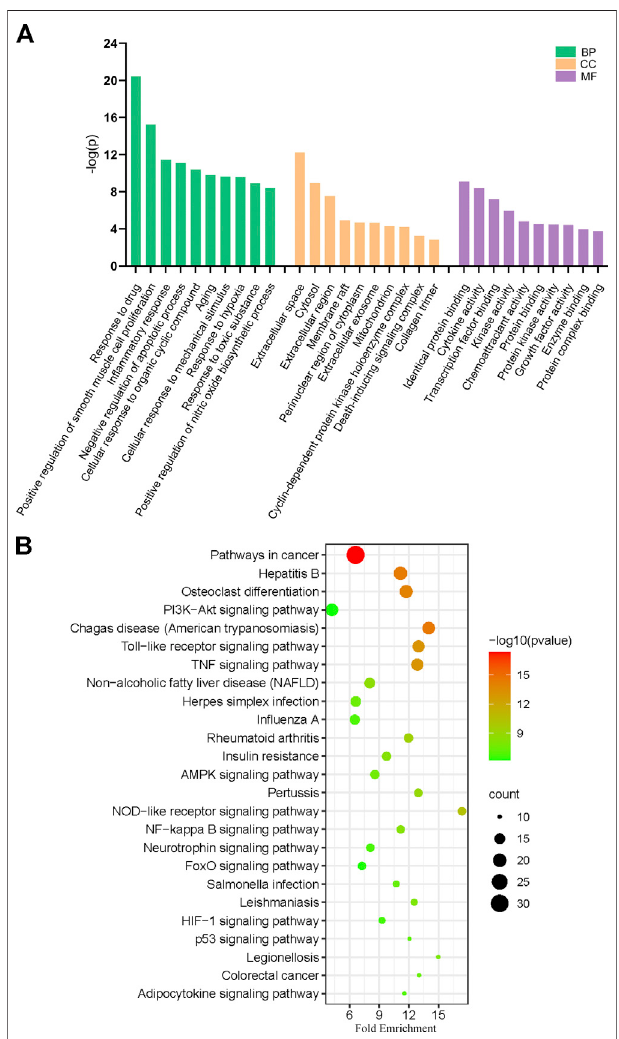
FIGURE 3 | (A) Gene ontology (GO) enrichment analysis for key targets (top10werelisted). (B) KEGGpathwayenrichmentanalysisofkeytargets(top 25 were listed); the abscissa label represents Fold Enrichment of